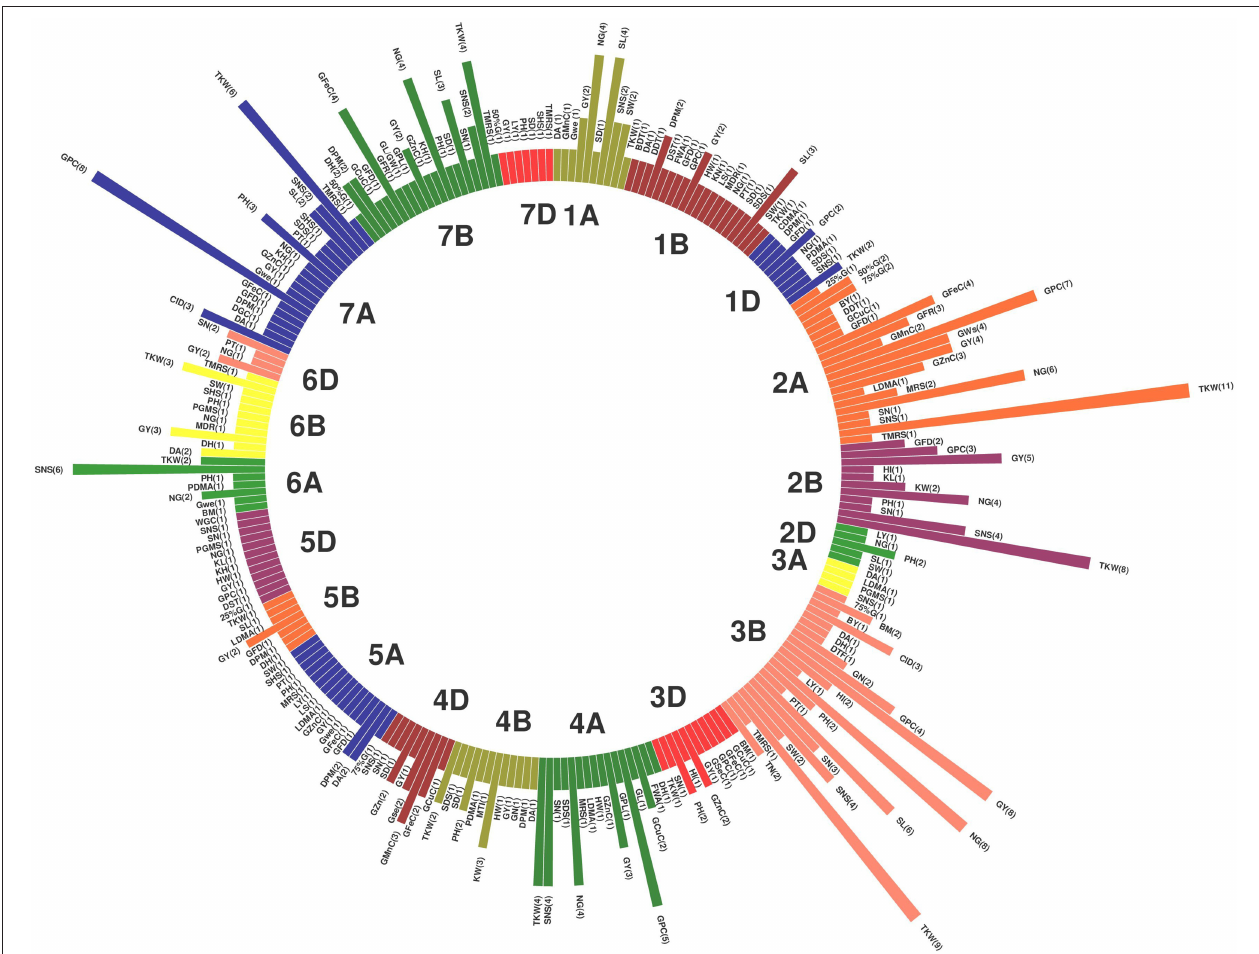
FIGURE 3 | Distribution of projected quantitative trait loci (QTLs) across the wheat ( Triticum aestivum L.) chromosomes. The numbers inside each parenthesis represent the number of